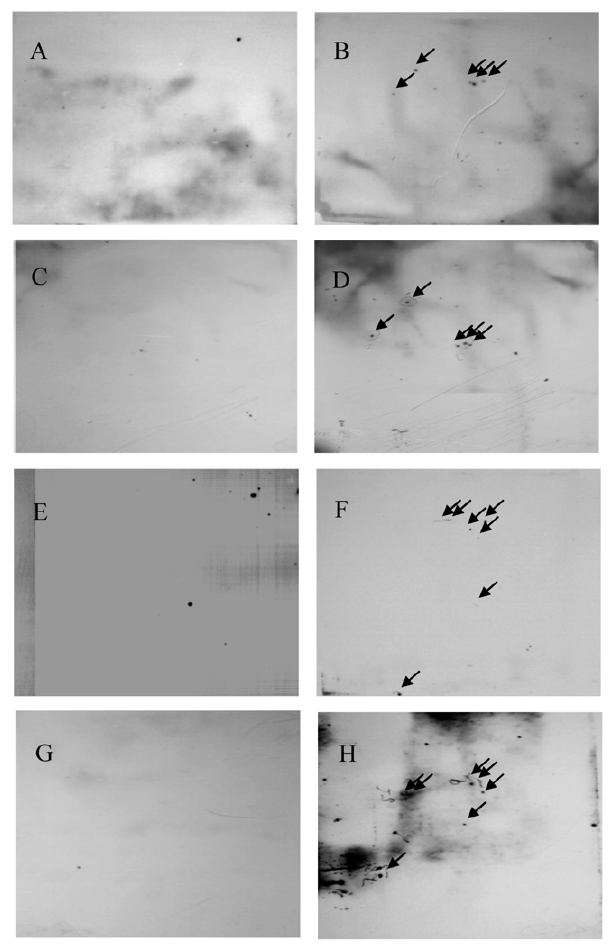
Figure 1. 2DE SDS-PAGE/immunoblot analysis of total cellular proteins of HEK293 cells infected with Ad5 or Ad35. The total protein of Ad5 (B, D) and Ad35 (F, H) infected and mock infected (A, C, E, G) HEK293 cells were separated by 2DE SDS-PAGE. 2DE SDS-PAGE gels were transferred onto a nitrocellulose membrane. Blots were probed with in-house rhesus monkeys anti-wild Ad5 (A, B) and Ad35 antibodies (E, F) or healthy adult human serum positive for Ad5 (C, D) and Ad35 (G, H), followed by incubation with the corresponding horse radish peroxidase (HRP)-conjugated goat anti monkey or goat anti human IgG secondary antibodies.